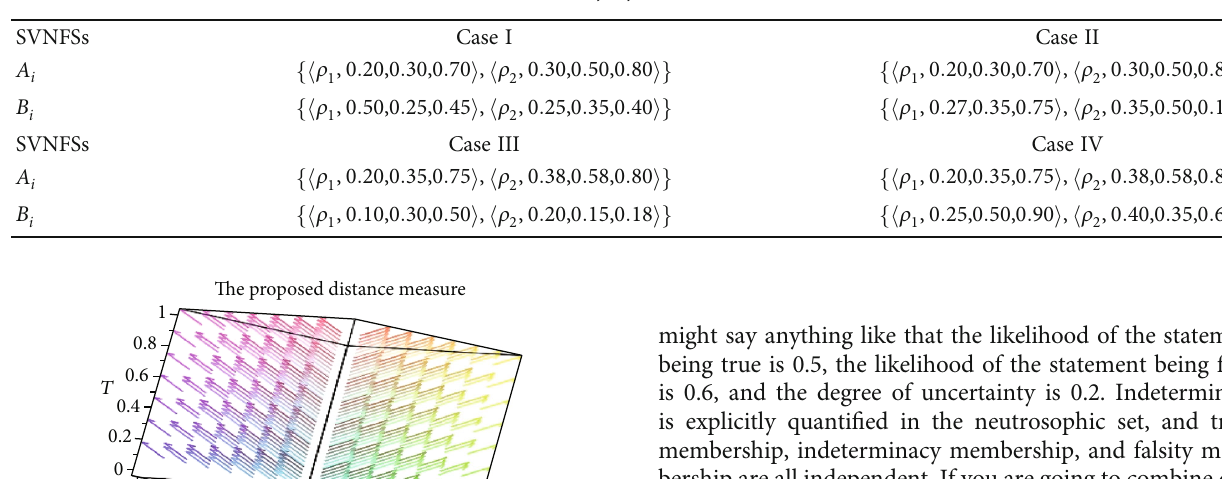
Y i , i downward case (